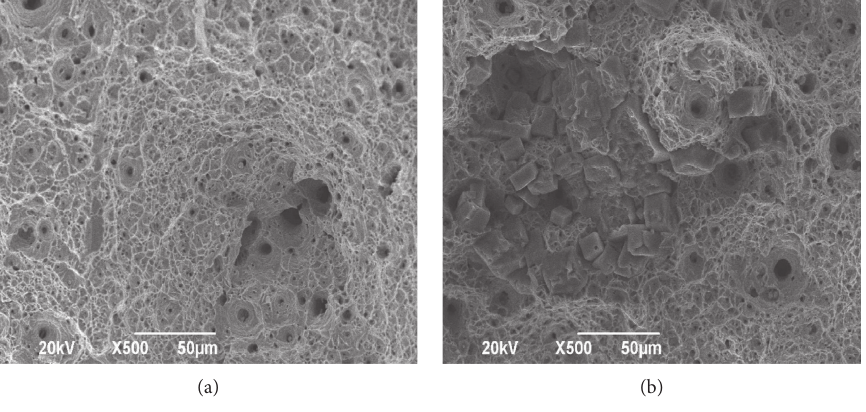
Figure 4: SEM images of fracture surface morphology of tensile test coupons ( T � 65 ° C, Cl − � 60,000mg/L): (a) Pco (b) Pco 2 � Table 5: Main mechanical properties of 316L stainless steel under different CO